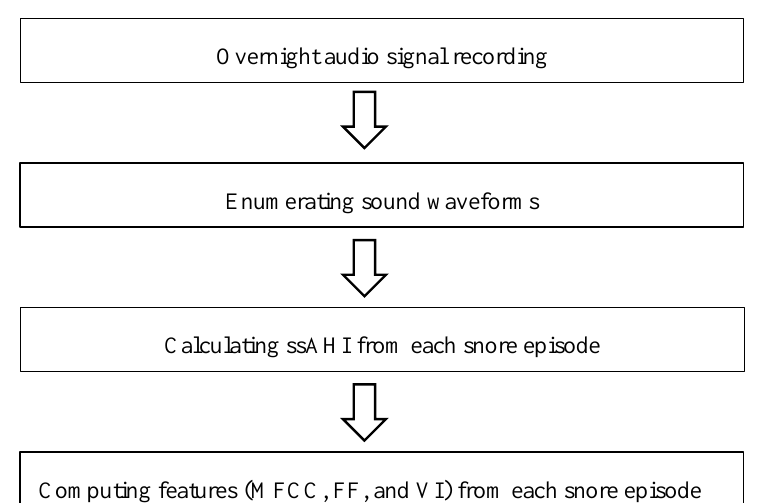
Table 1. Flow chart of feature extraction.